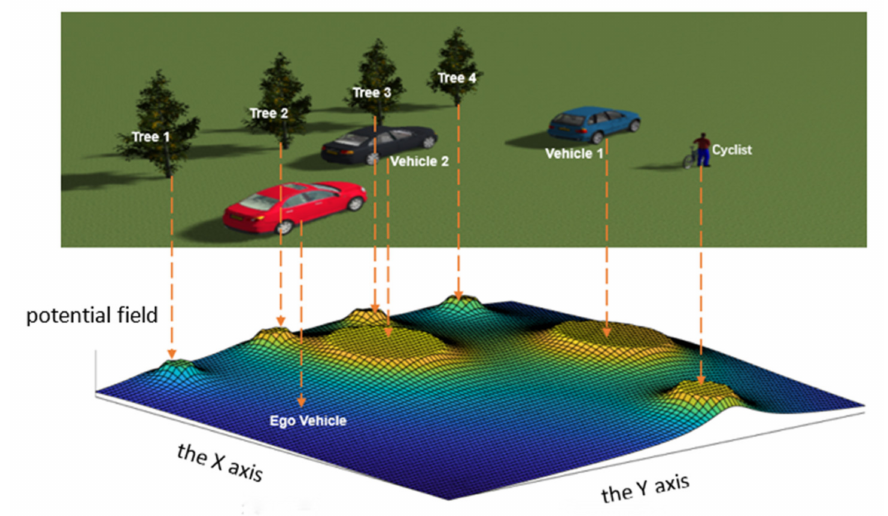
Figure 2. The results of potential field of the off-road road traffic